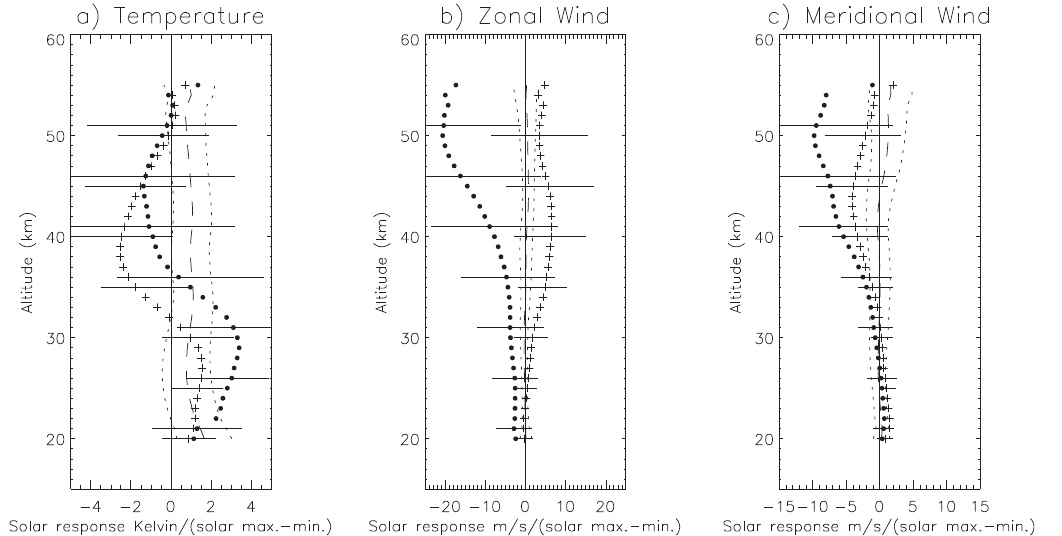
2 r confidence intervals. Results for winter month (December- January-February) analyses are shown by crosses . Results for January monthly analyses are noted by circles . Horizontal lines are